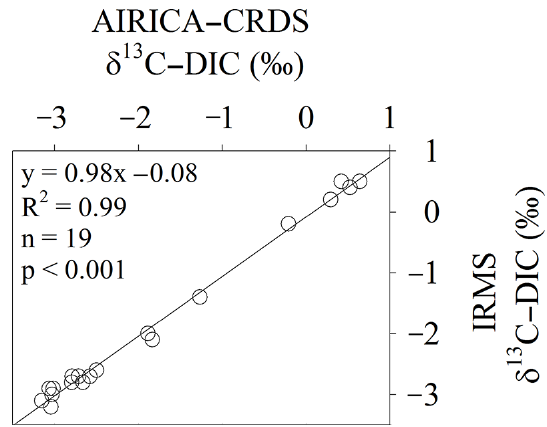
Figure 3. Comparison of AIRICA-CRDS δ 13 C-DIC versus IRMS δ 13